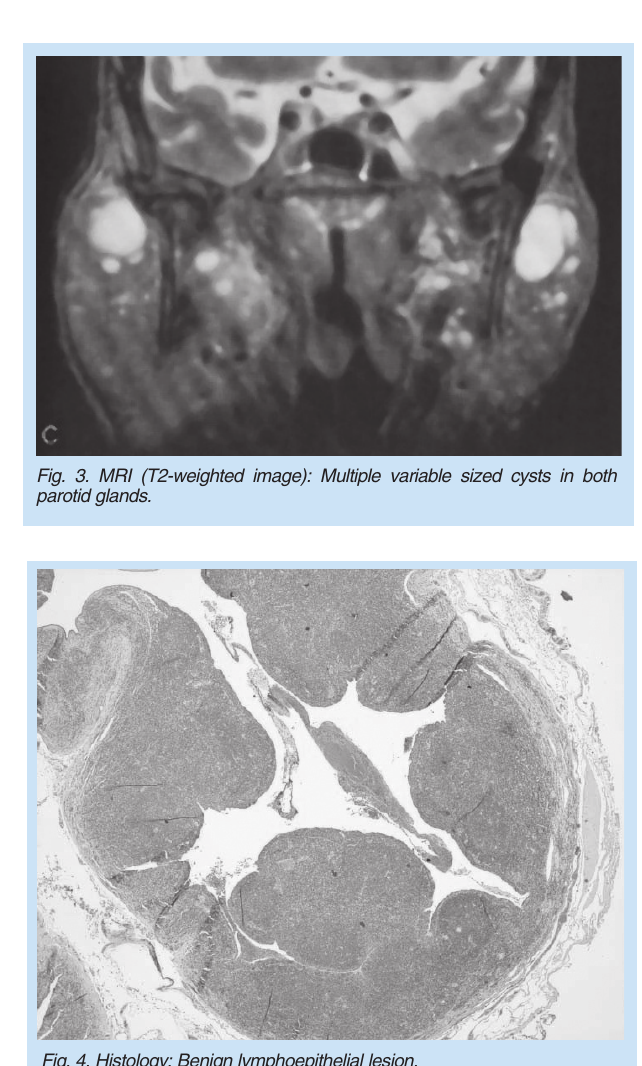
Fig. 4. Histology: Benign lymphoepithelial